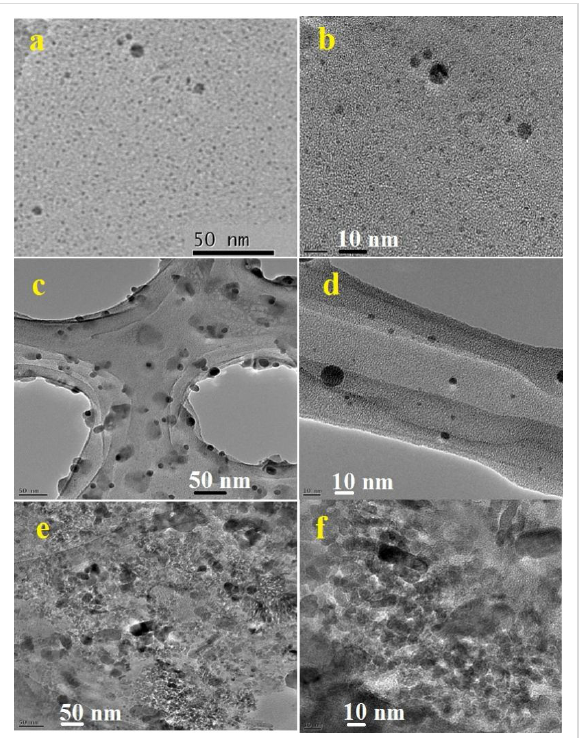
Figure 7: TEM image of CN nanoflake and quantum dot samples under heating at 190 °C for 5 h (a,b), 170 °C for 5 h (c,d), and 150 °C for 5 h (e,f).